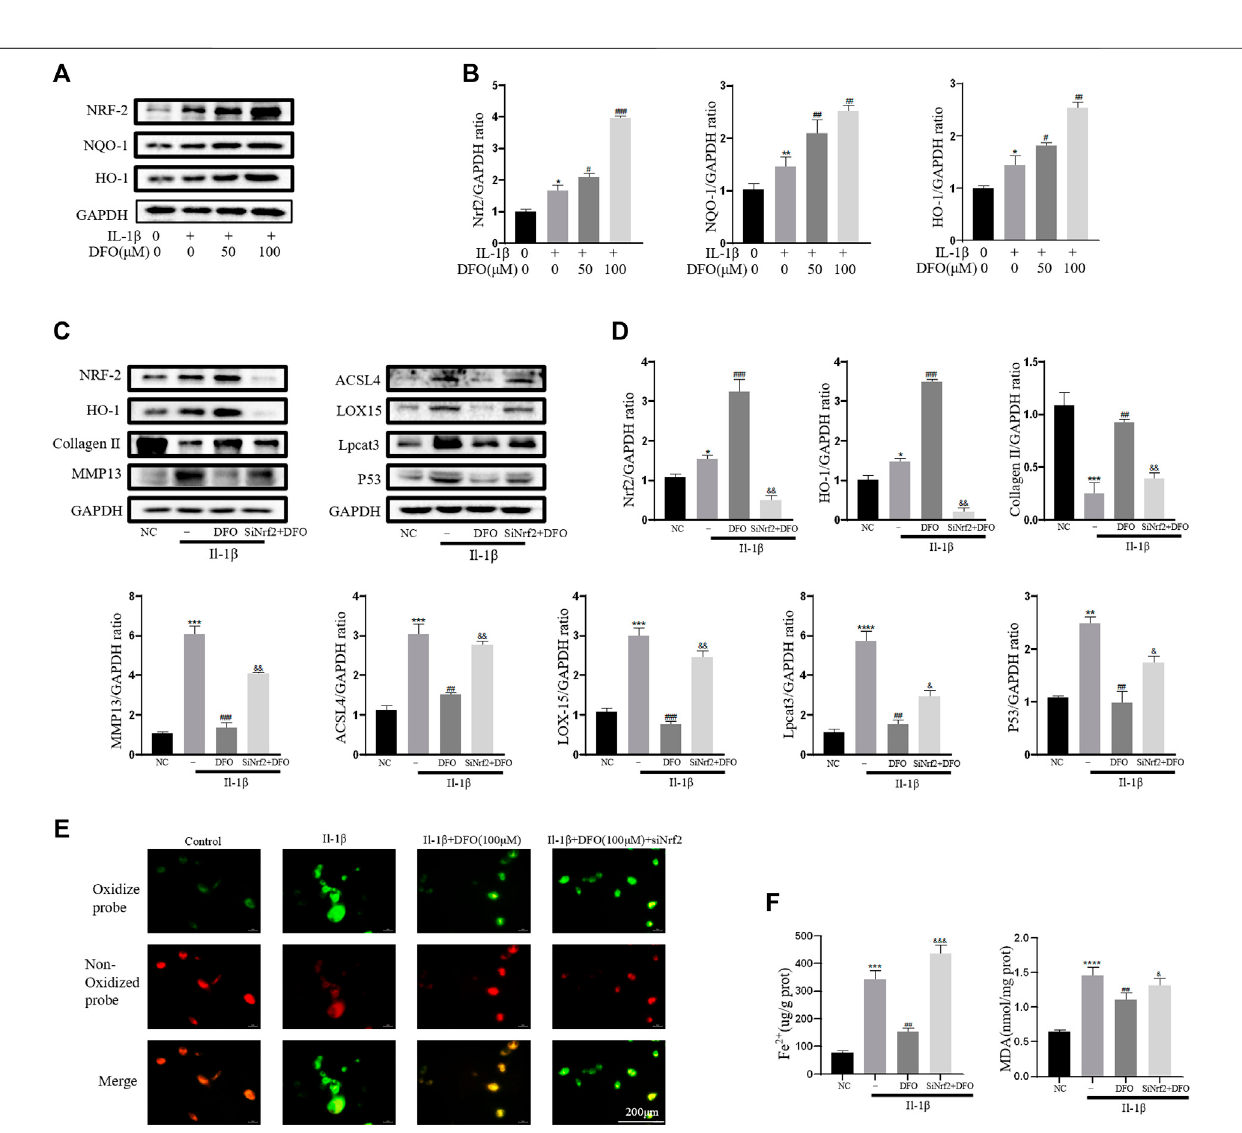
FIGURE6 | Nrf2 signaling mediated protective effects ofDFO on OAchondrocyte. (A,B) The protein expression levels ofNrf2,HO-1,and NQO-1 when treated by IL-1 β (10 ng/ml)with50and100 μ MDFOorequalvolumeofDMSOweredetectedbyWesternblot,andbanddensityratiosofNrf2,HO-1,andNQO-1toGAPDHinthe Western blots were quanti fi ed by densitometry ( n = 3). (C,D) The protein levels of Nrf2, HO-1, collagen Ⅱ , MMP13, ACSL4, LOX15, lpcat3, and P53 when treated by IL- 1 β (10 ng/ml) with si-Nrf2 or negative control were detected by Western blot, and band density ratios of Nrf2, HO-1, collagen Ⅱ , MMP13, ACSL4, LOX15, lpcat3, and P53 to GAPDH in the Western blots were quanti fi ed by densitometry ( n = 3). (E) Intracellular lipid-ROS level detected by C11 BODIPY fl uorescent probe (scale bar: 200 µm).Red, reducedform ofC11-BODIPY;green, oxidized form ofC11-BODIPY. (F) The intracellular level ofMDA and Fe 2+ wasdetermined usingthe MDA assaykit and iron assay kit ( n = 3). * p < 0.05 versus control, ** p < 0.01 versus control, *** p < 0.001 versus control, **** p < 0.0001 versus control, # p < 0.05 versus IL-1 β – treated group, ## p < 0.01 versus IL-1 β – treated group, ### p < 0.001 versus IL-1 β – treated group, & p < 0.05 versus IL-1 β +DFO group, && p < 0.01 versus IL-1 β +DFO group, &&& p < 0.001 versus IL-1 β +DFO group, and &&&& p < 0.0001 versus IL-1 β +DFO group. Error bars represent SD.